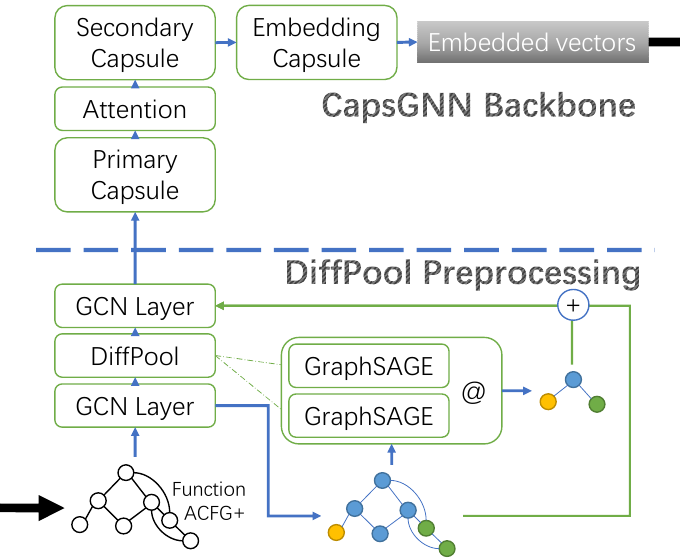
Figure 4. Network structure of the graph embedding